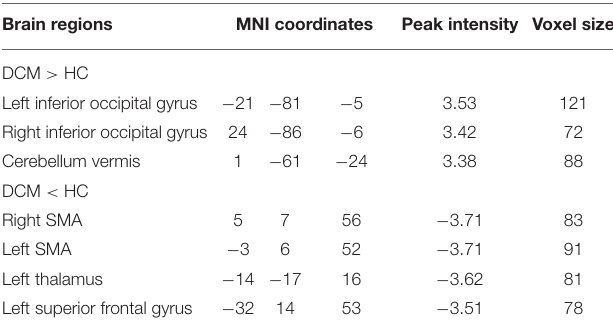
TABLE 2 | Detailed information on intergroup global functional connectivity density (gFCD) differences. Brain regions